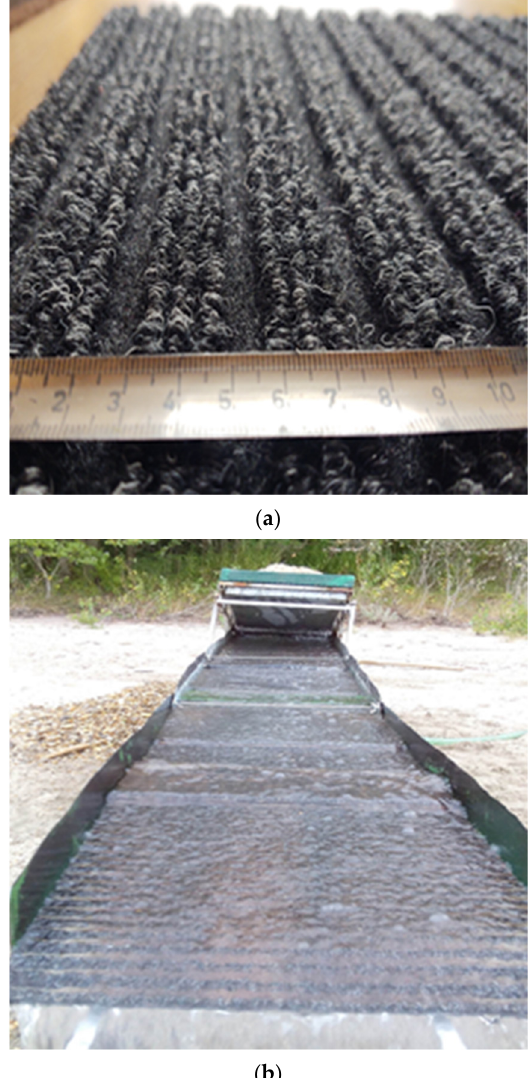
Figure 1. Detailed picture of the wash carpet ( a ). Overlook at the riffle sluice ( b